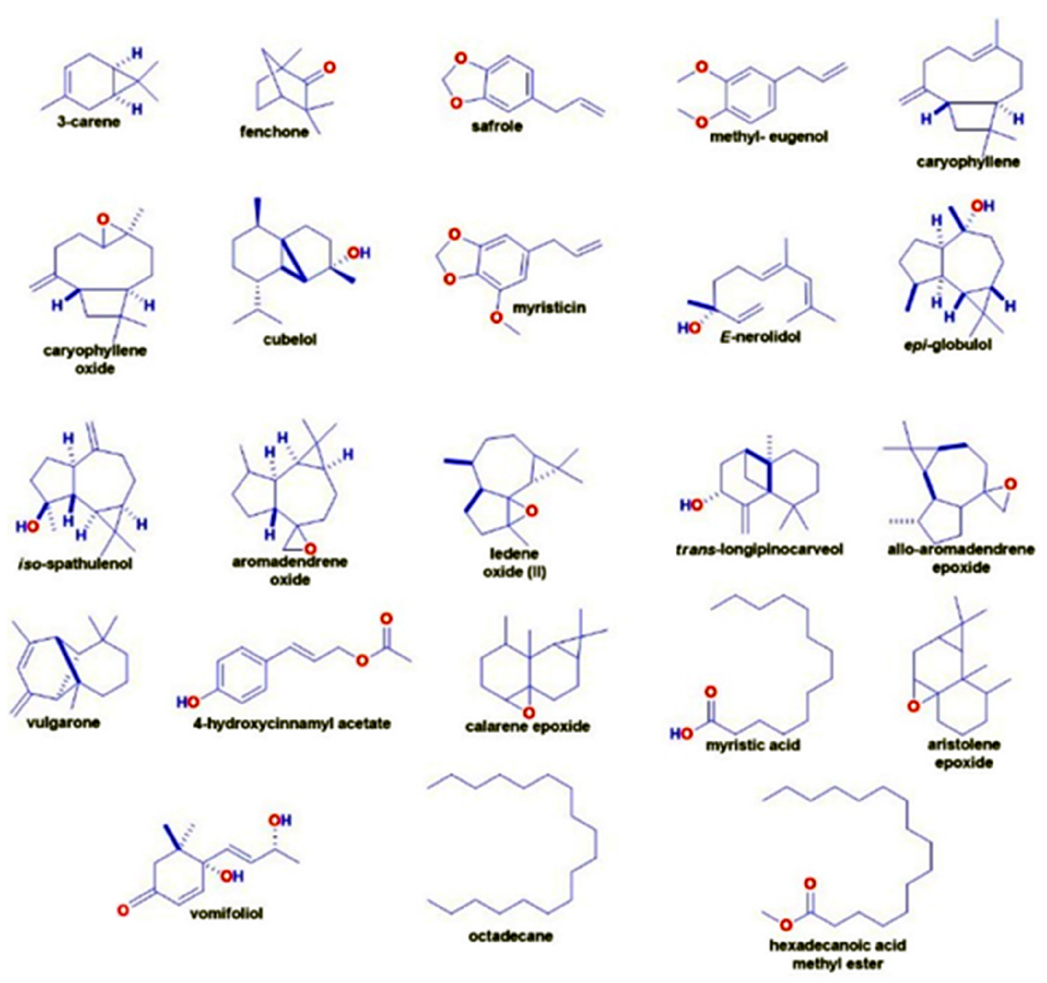
Figure 3. The chemical structure of essential oils present in Piper cordoncillo essential oil.